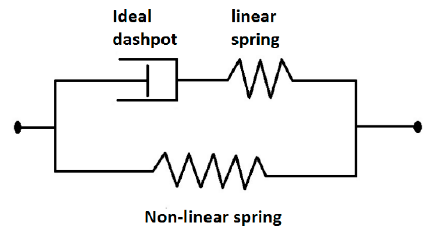
Figure 11. Rheological model for EPI film composed of two Maxwell elements in parallel.